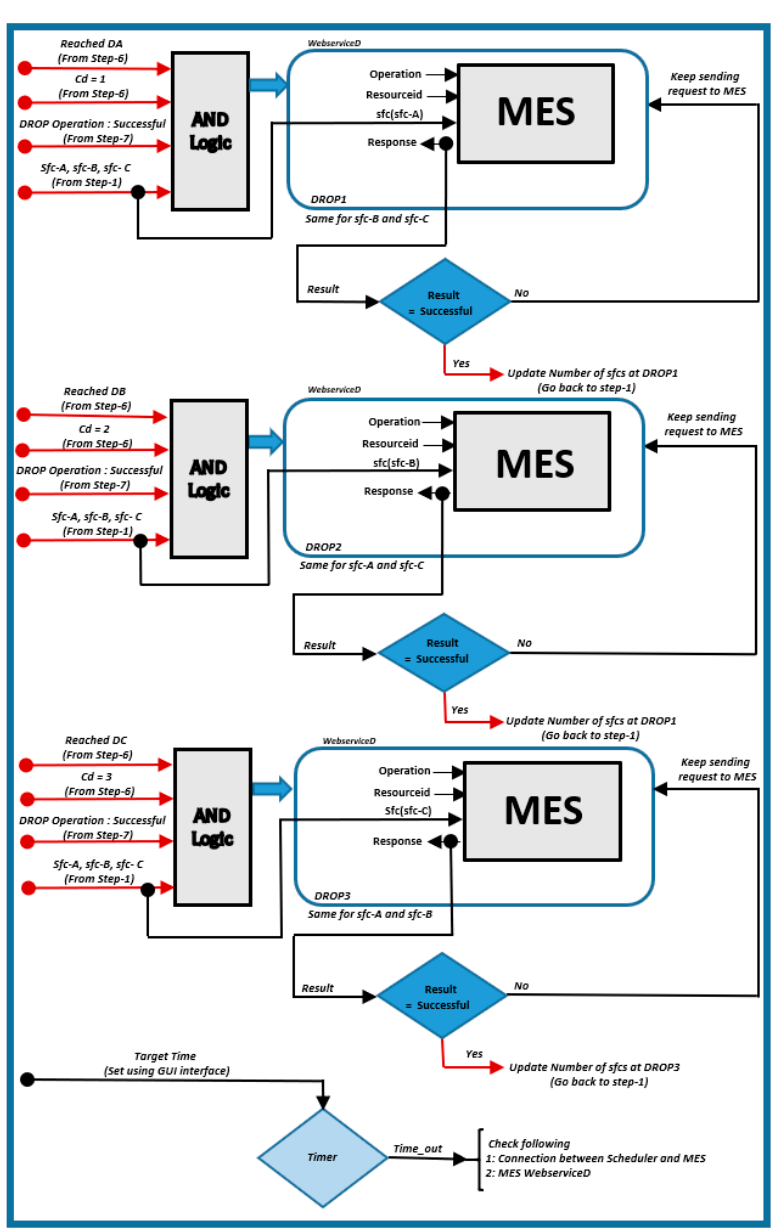
Figure 17. Send Product ‐ Drop confirmation to MES.